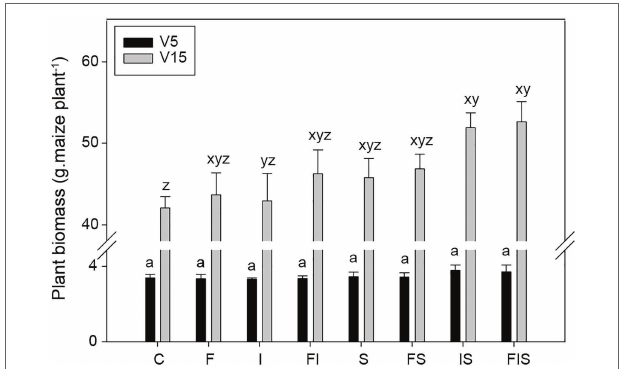
FIGURE 3 | Biomass average of maize plants collected at V5 ( n = 12) and V15 ( n = 6). Bars with the same letter are not significantly different ( p < 0.05). Two groups of series of letters compare treatments from distinctly stage periods ( a for V5 and xyz for V15). Treatments: C, Control; F, Urea- topdressing fertilization at V5; I, A. brasilense inoculant on seeds sowing; FI, F + I; S, Maize stover coverage; FS, F + S; IS, I + S; FIS, F + I + S.